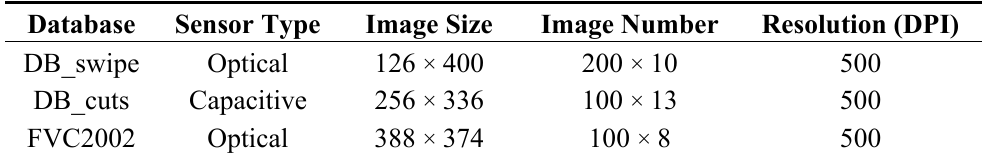
Table 1. Description of Databases.